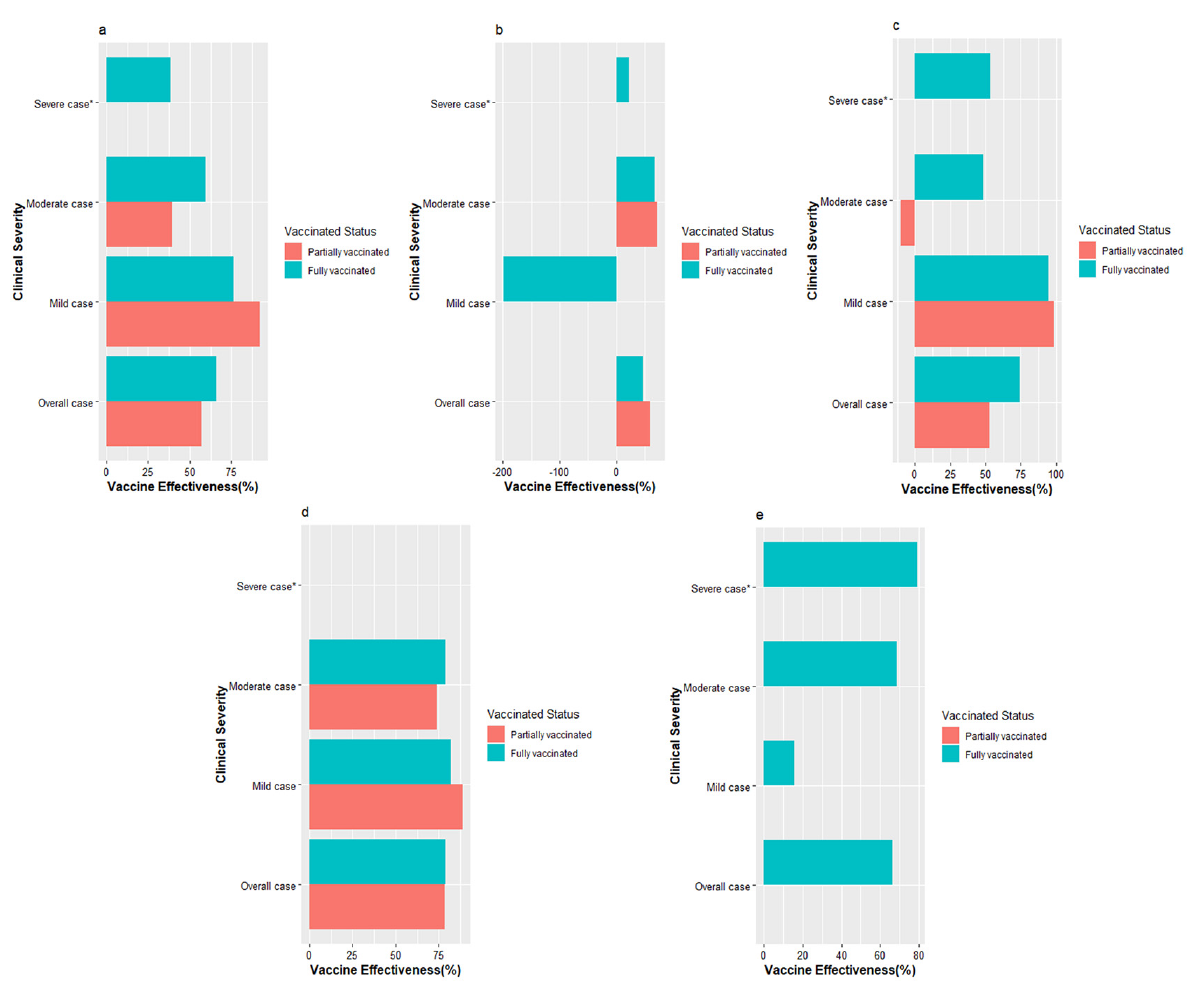
Figure 3. Effectiveness of the inactivated vaccines against different severity of COVID − 19 associated with the Delta variant strain. ( a ) Effectiveness in the whole population. The abscissa is vaccine effectiveness (%) and the ordinate are different clinical severity. The bars represent the estimated value of VE. Different colors indicate different vaccination statuses; ( b ) Effectiveness in males; ( c ) Effectiveness in females; ( d ) Effectiveness in the study participants aged 19–40 years; ( e ) Effectiveness in study participants aged 41–60 years. Note: * partially vaccinated was used as reference because of lacking data on unvaccinated group.